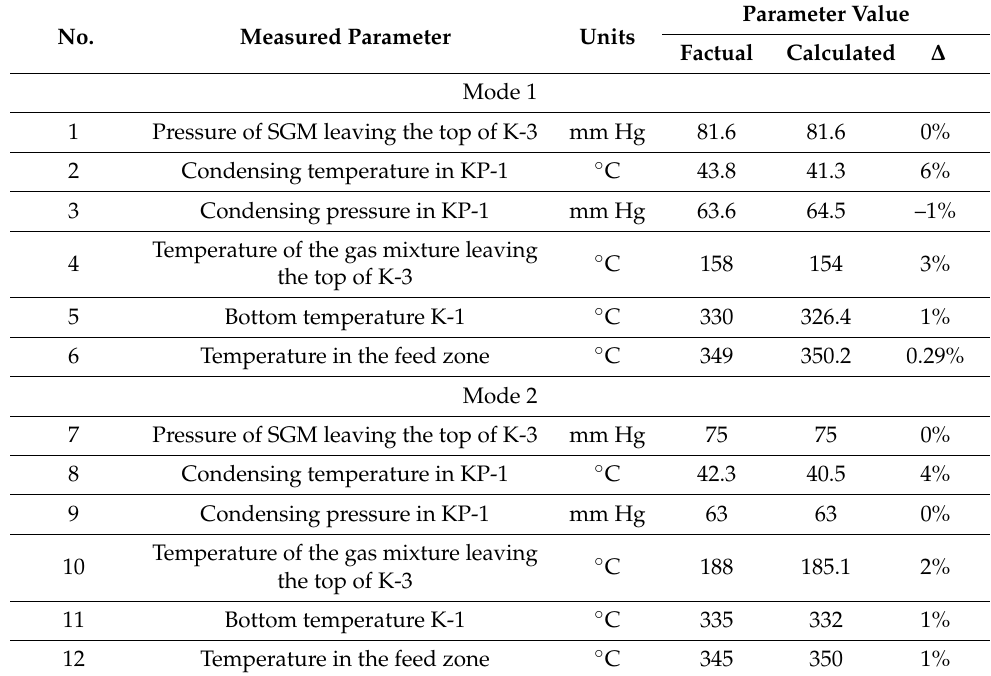
Table 15. Comparison of technological and design parameters of the